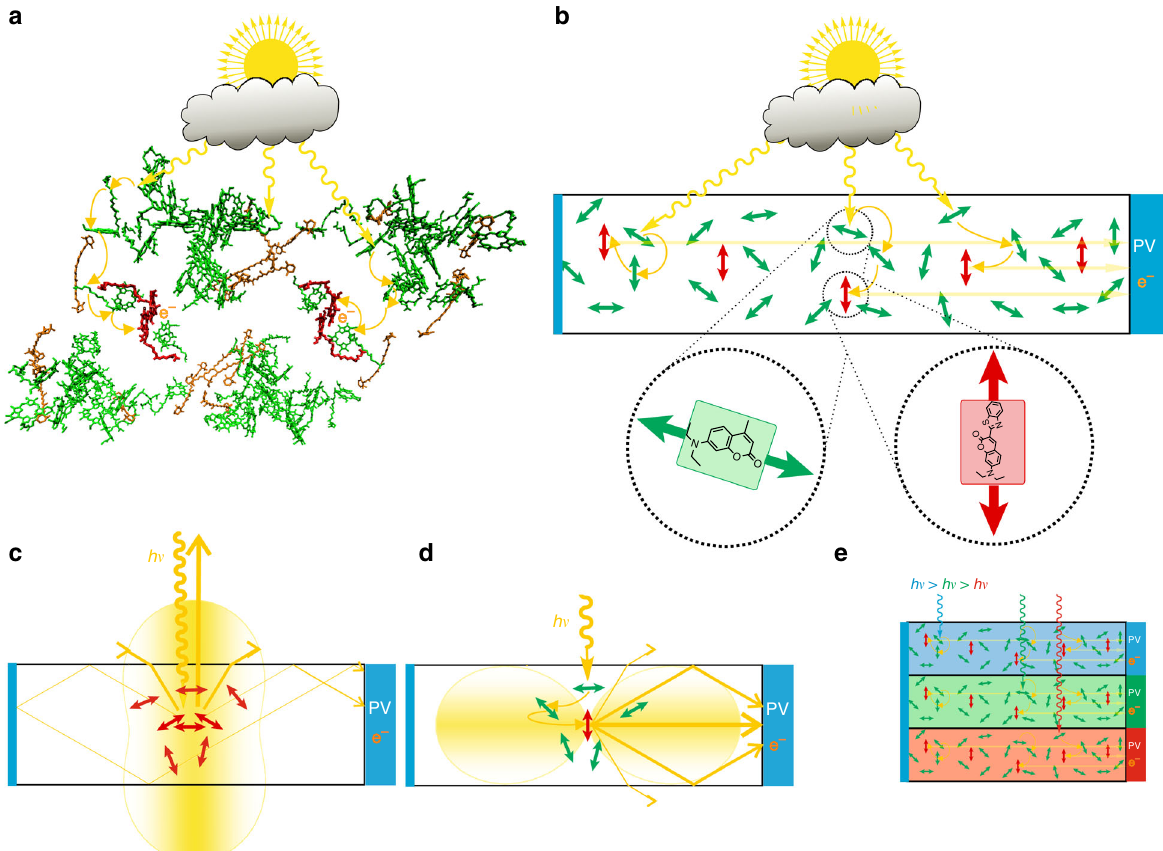
Fig. 1 Natural and arti fi cial light harvesting. a Natural light-harvesting pigment protein complexes absorb diffuse light incident from any direction and ef fi ciently funnel the energy via several ultrafast steps to special pigments converting the energy into a charge separation. Structural data taken from Tanaka et al. 60 and visualized with VMD (Visual Molecular Dynamics) 61 . b Arti fi cial light harvesting by several randomly oriented, light-absorbing donor pigments (green) funneling the energy to individual acceptor molecules (red) that all have the same orientation with respect to the laboratory frame. As light is preferentially re-emitted perpendicular to the acceptor dipole moments (red), this allows ef fi cient re-direction of the photons into angle ranges favorable for high ef fi cient photovoltaics (PV) and cost-effective total internal re fl ection waveguiding (funneling diffuse light redirection, FunDiLight). c In classical solar concentrator architectures, molecules are excited that emit preferentially back in directions parallel to the excitation (Photoselection). In addition, full light absorption needs high pigment concentrations inevitably causing reabsorption losses by the same pigments. d In contrast, FunDiLight still allows absorbing > 99% of donor wavelength light but with much lower acceptor emission re-absorption and ~90% photon re-direction into angles suitable for total internal re fl ection waveguiding. e The concept also allows for stacked structures redirecting light to high ef fi cient photovoltaics for each spectral range. Blue bars on the left in b – e indicate